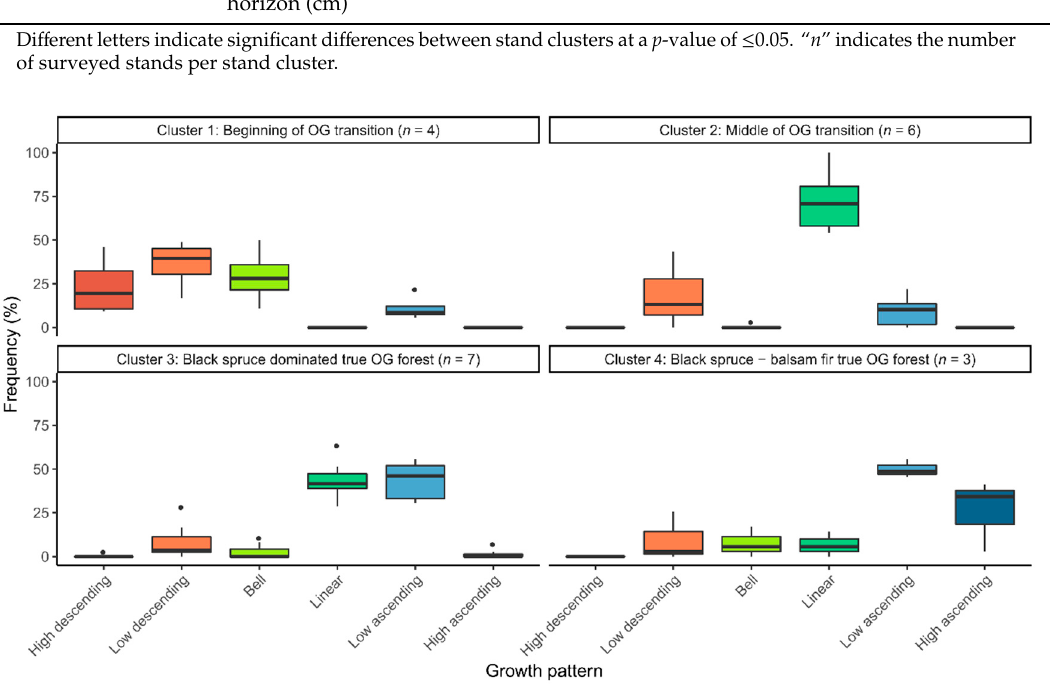
Figure 4. Boxplots of the frequency of growth patterns in the four stand clusters (SCs) identified using a k-means cluster algorithm. OG: old growth. “ n ” indicates the number of surveyed sites per SC.